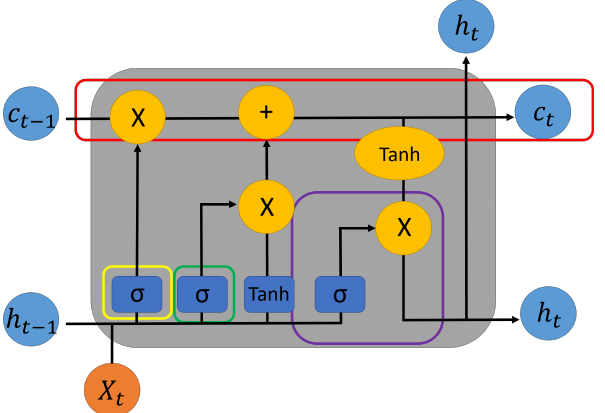
Figure 3. The architecture of an LSTM cell with the input cell circled in green, the forget cell in yellow, the cell state in red, and finally, the output gate in